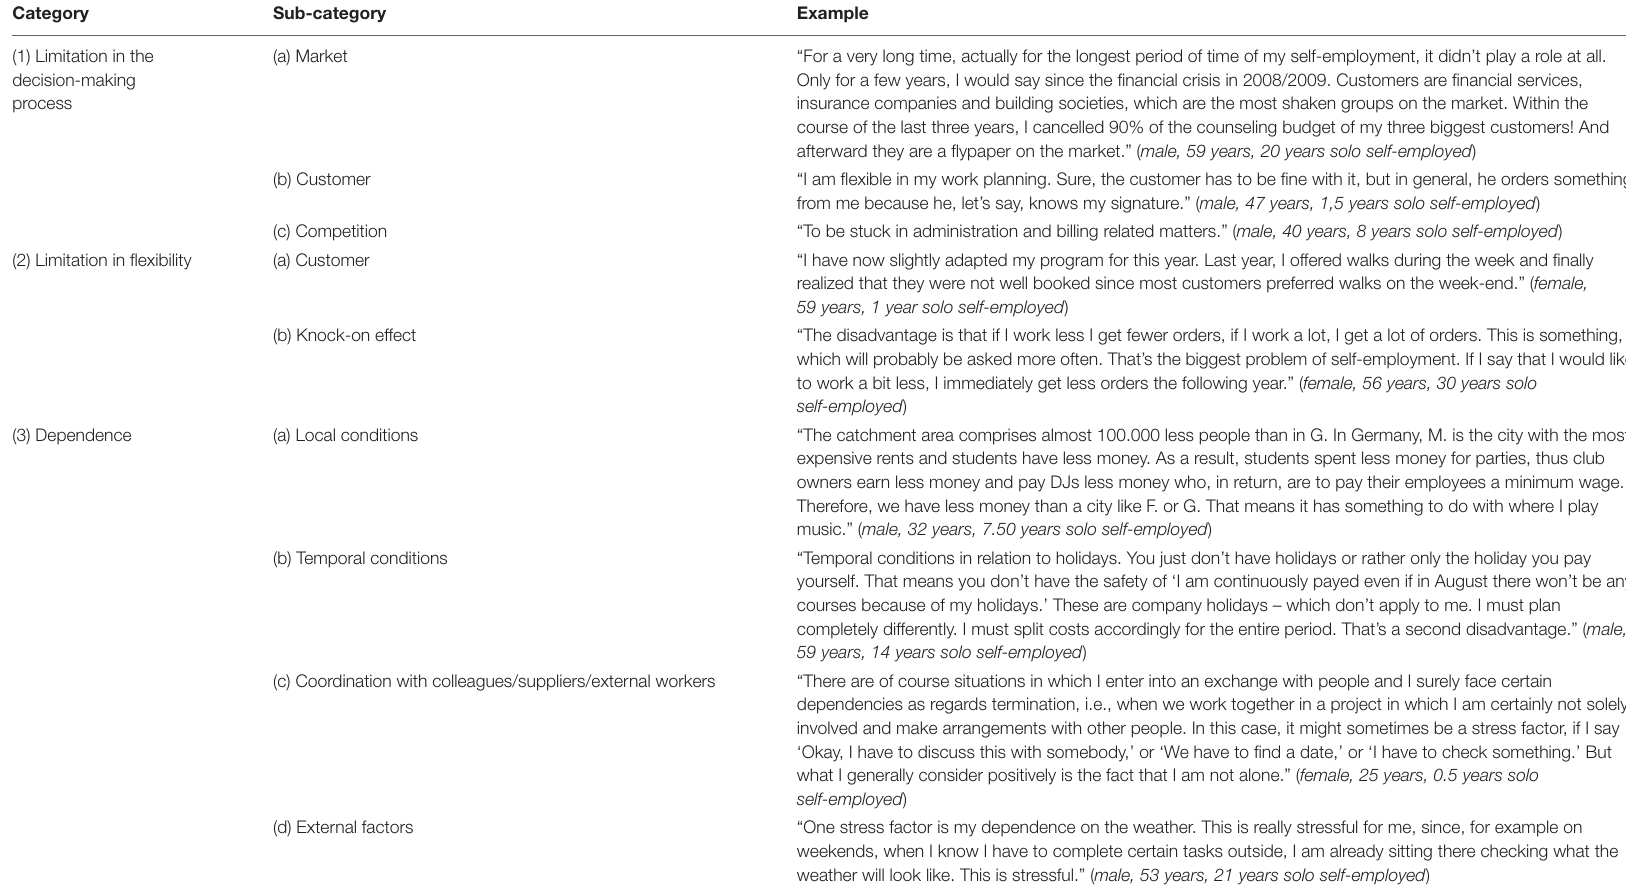
TABLE 4 | Stress factors in the market and product context. Category